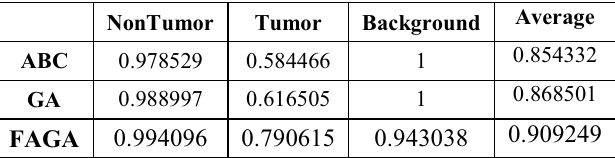
Table 6. Performance comparison using fifth image in terms of accuracy NonTumor Tumor Background Average